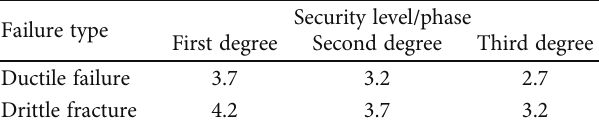
Table 11: Reliability index of the building structure.